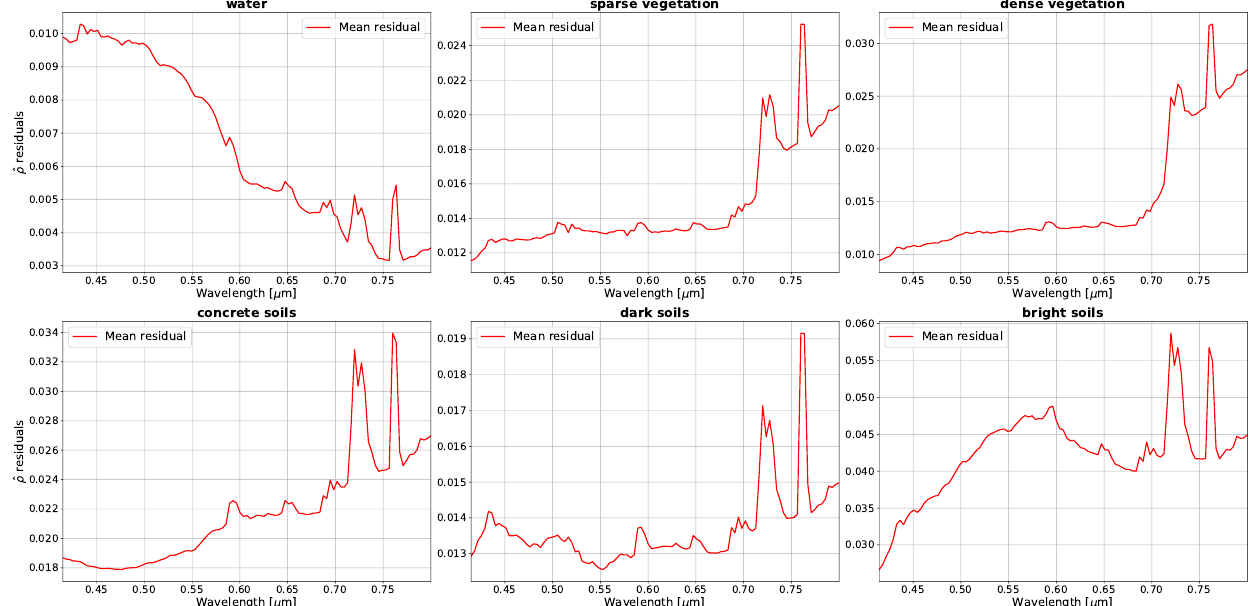
Figure 9. Mean standard deviation of posteriori uncertainties on surface reflectance as a function of wavelength and by surface